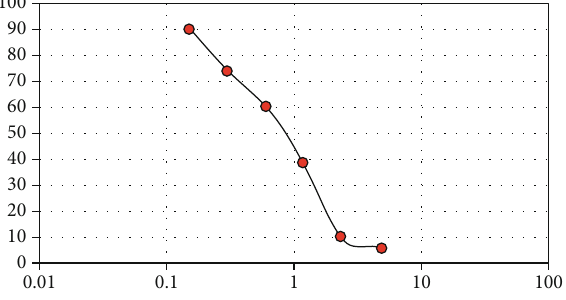
Figure 2: Gradation curves of fi ne aggregate.